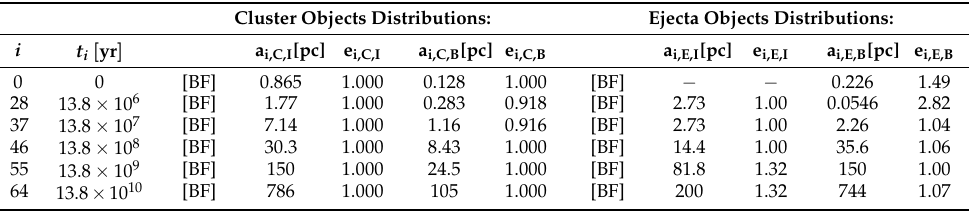
Table 17. Shown are the cluster and ejecta BF values for the orbital eccentricity and semi-major axis distribution, ρ ( e i , j , a i , j , t ) , from Figure 14, where i = C,E stand for the separate cluster and ejecta populations, and j = I,B stands for the separate isolated and bounded population distributions at selected times. Cluster Objects